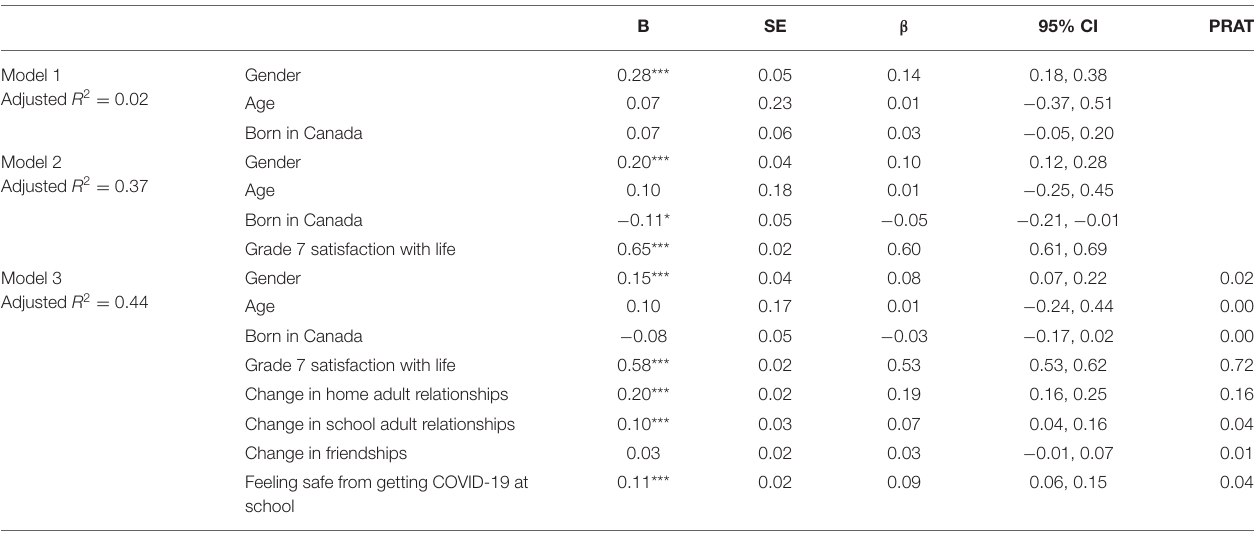
B SE β 95% CI PRATT